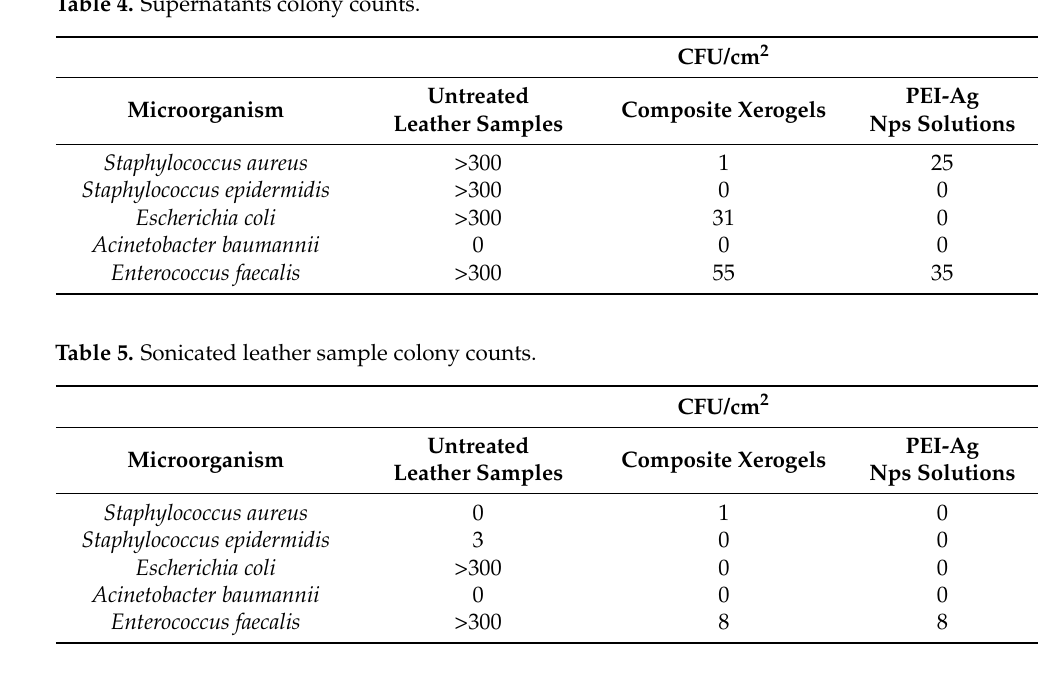
Table 4. Supernatants colony counts.